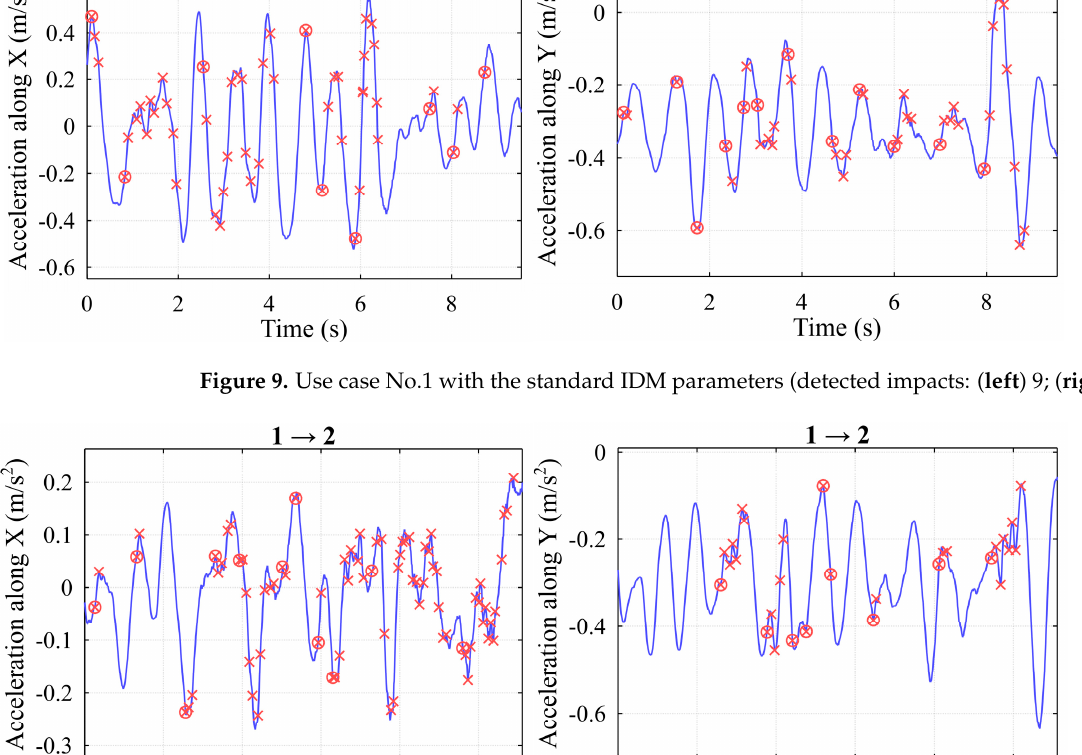
Figure 11. Use case No.3 with the standard IDM parameters (detected impacts: ( left ) 16; ( right ) 2). Change in the threshold gave promising results. A 10% increase resulted in one ad- ditional impact detected in the first use case along the Y-axis (refer to Figure 12). Figure 12. Use case No. 1 with the increased threshold (detected impacts: ( left ) 9; ( right ) 13).